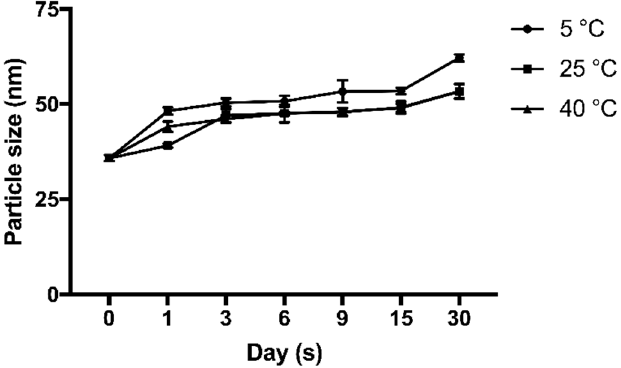
◦ C, 25 ◦ C and 40 ◦ C for 1 month ( n =